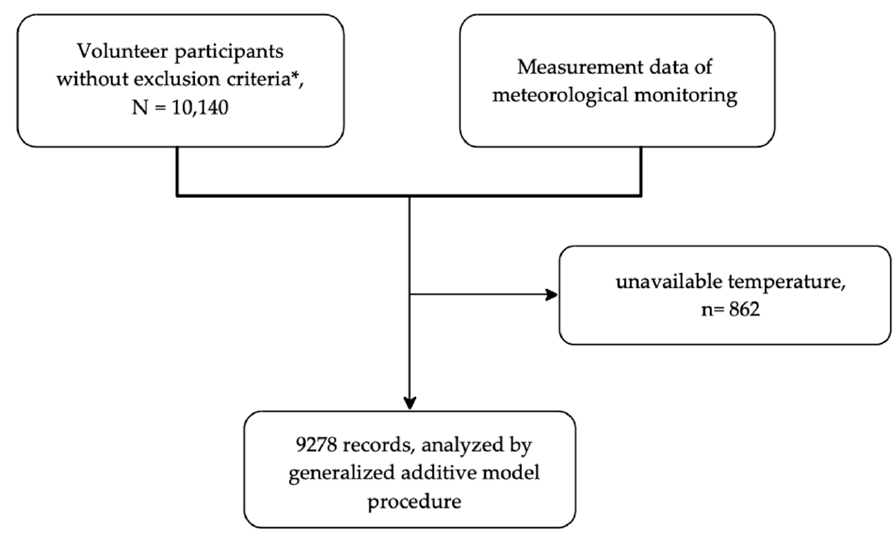
Figure 1. Brief of including records of participants. * exclusion criteria: pregnancy, current malignancy diseases, history of auto-immune diseases, status of infectious disease or fever. Table 1. Demographic characteristics of participants.